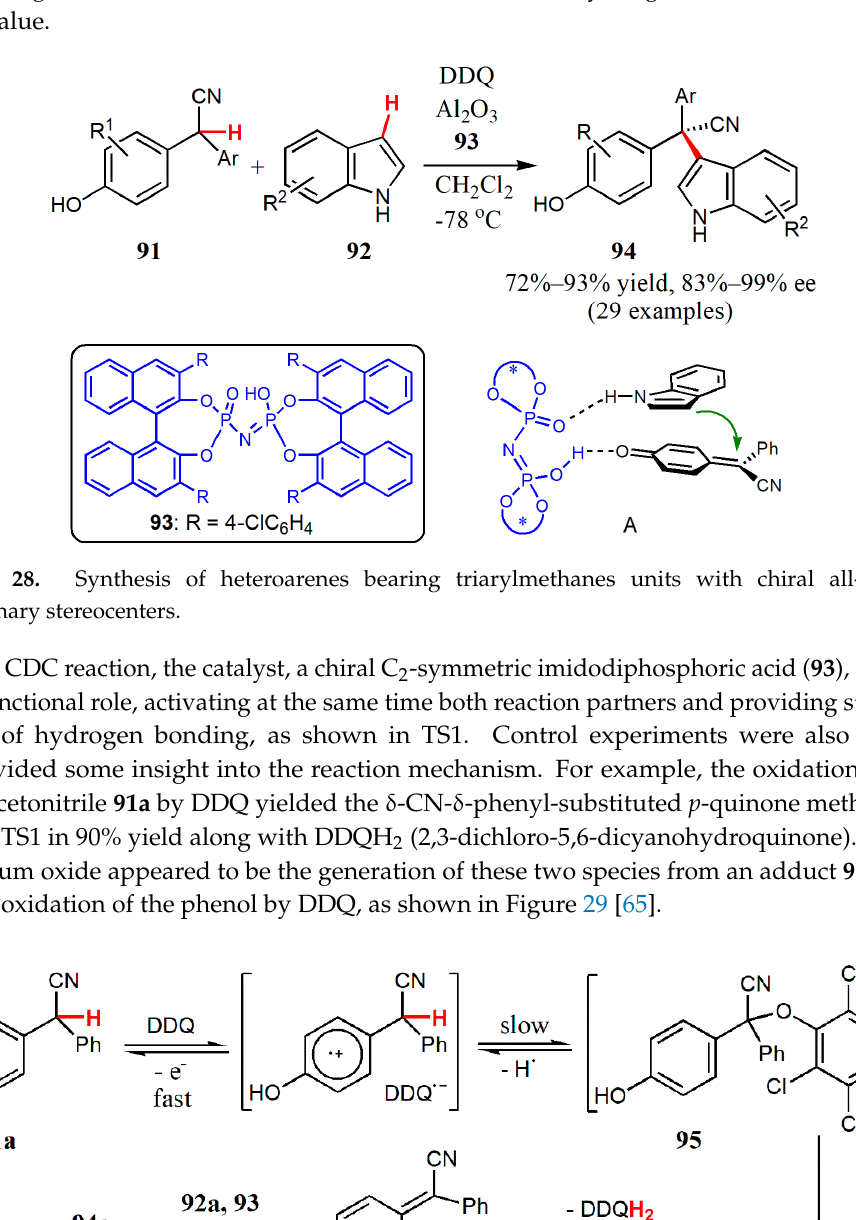
Figure 29. The mechanism proposed for the CDC of heteroarenes.